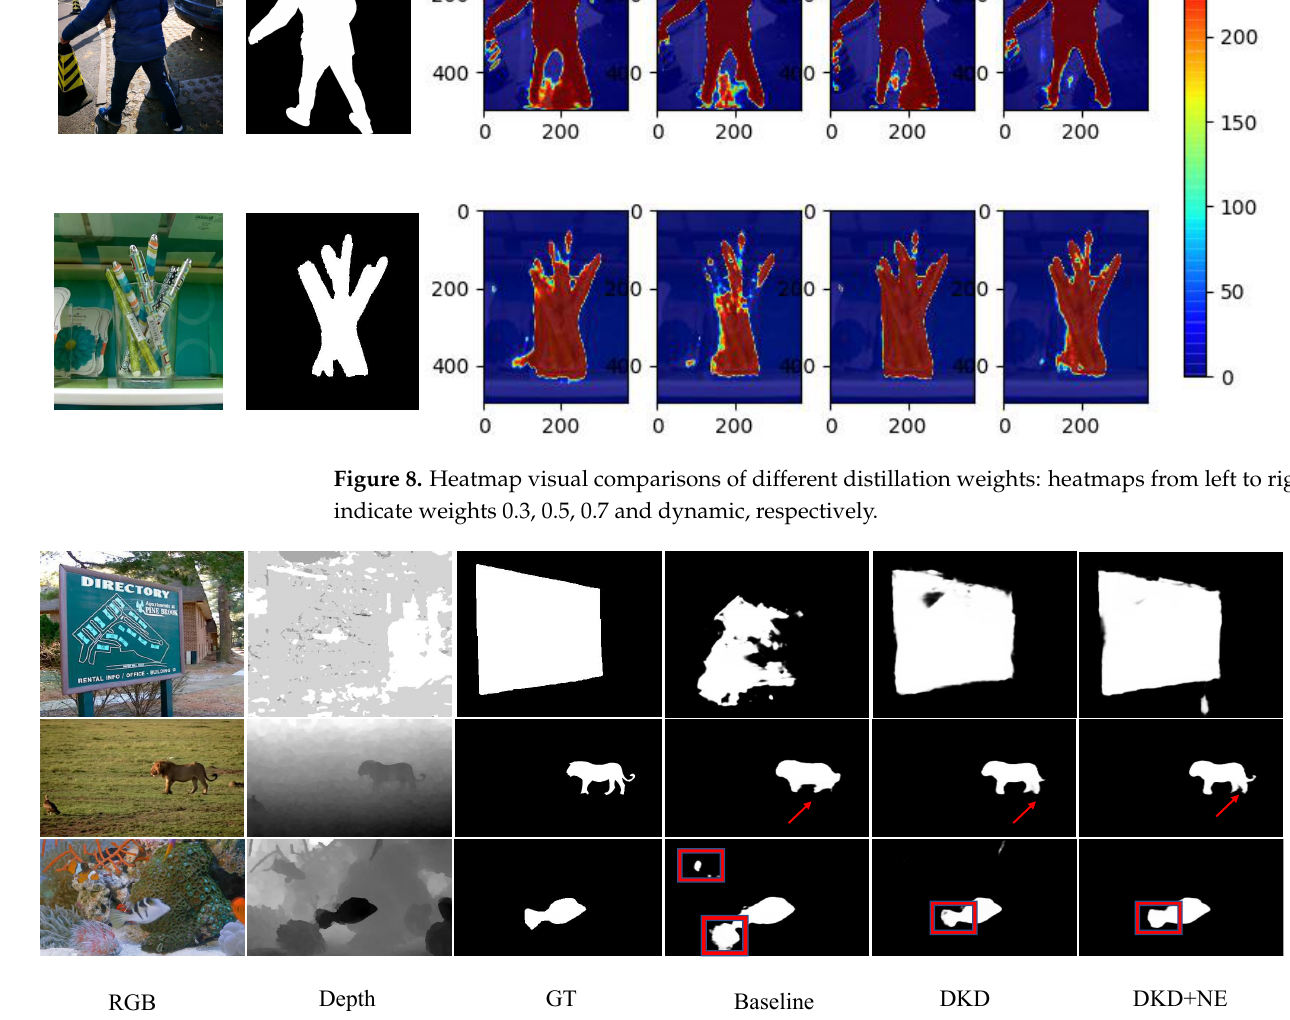
Figure 9. Ablation studies of the proposed methods. Baseline represents that the student net- work is only trained on cross-entropy loss. DKD represents the proposed DKD and NE means noise